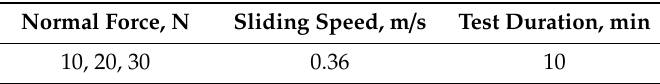
Table 2. Tribological parameters.